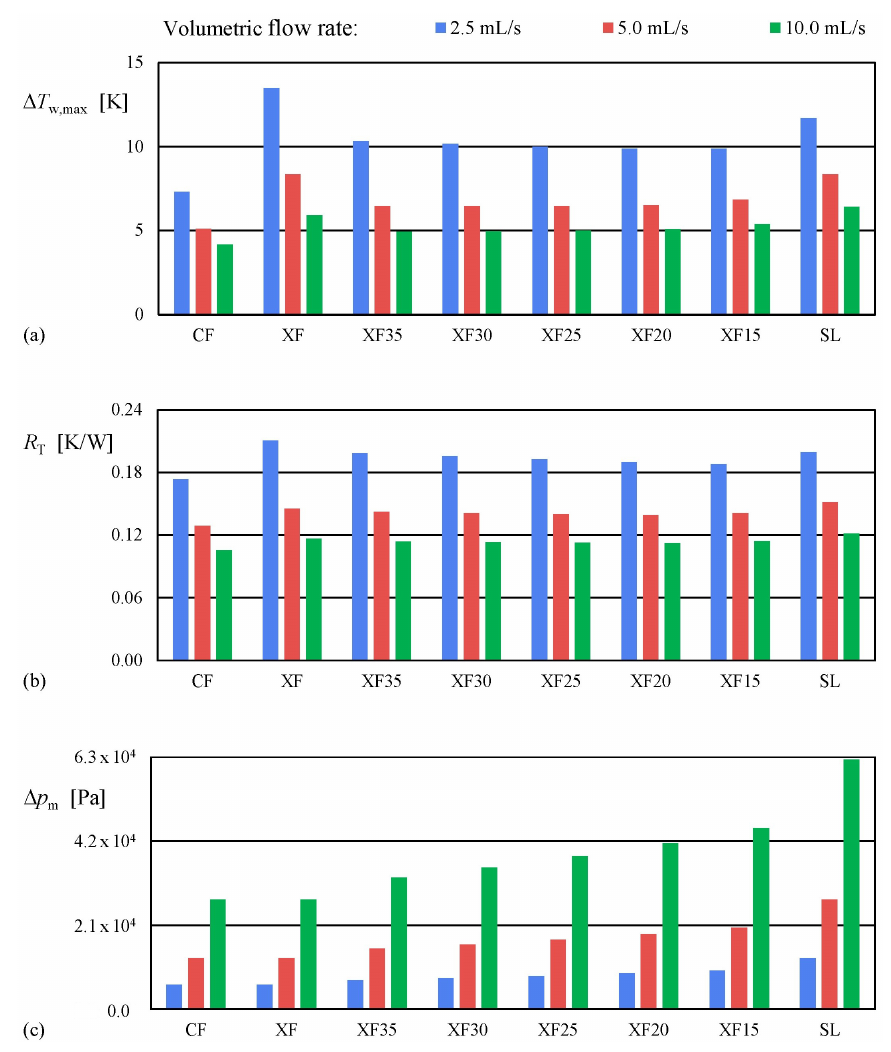
Figure 11. Quantitative results: ( a ) maximum bottom wall temperature change ∆ T w,max = T w,max − T w,min ; ( b ) total thermal resistance R T ; ( c ) pressure drop ∆ p m in the microchannels for all